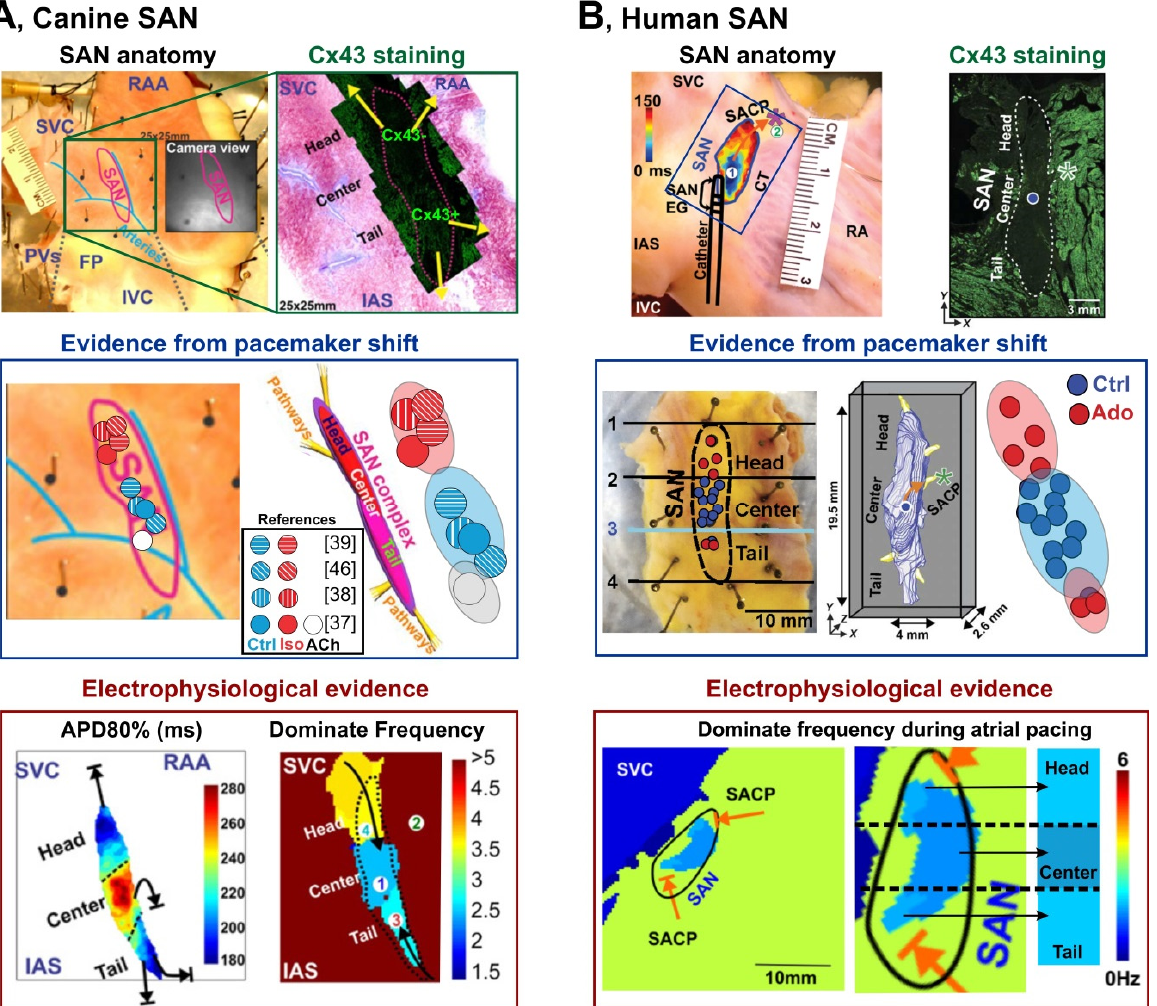
Figure 2. Evidence of several pacemaker clusters in canine and human SANs. Figures are modified from Lou [50] and Li [4]. ( A ) Evidence supporting existence of pacemaker clusters in the canine SAN. Three pacemaker clusters located at head, center and tail SAN were identified during autonomic stimulation. Similar to mouse and rabbit SANs, Iso and ACh shifted the leading pacemaker from the center cluster (blue dots in a light blue area) into superior (red dots in a light red area, Iso) and inferior (white dots in a gray area, ACh) clusters. The figure summarizes four studies that optically located the leading pacemaker in the canine SAN [42–44,51]. Immunofluorescent detection showed various Cx43 expression patterns in distinct intranodal clusters. Further evidence from electrophysiological characterization also supported the existence of pacemaker clusters located at head, center and tail SAN, which is consistent with the findings from the pacemaker shift. Three clusters showed different action potential duration (APD) and dominate frequency distribution measured during atrial pacing. ( B ) Evidence supporting existence of multiple pacemakers in the human SAN. Similar to the canine SAN, three pacemaker clusters were identified in the human SAN evidenced from pacemaker shift and dominant frequency distribution during atrial pacing. Adenosine (Ado) shifted the leading pacemaker outside the central SAN majorly into the superior cluster and rarely to the inferior cluster. Green *: sinus exit